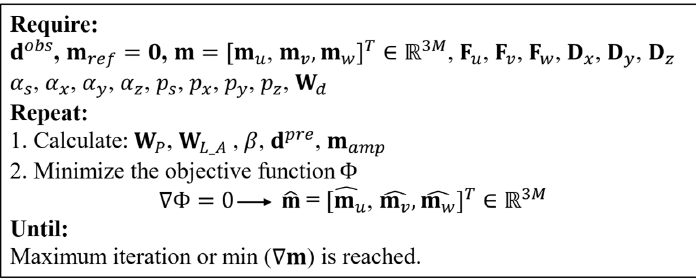
Figure 1. Inversion process based on the method proposed in this paper.